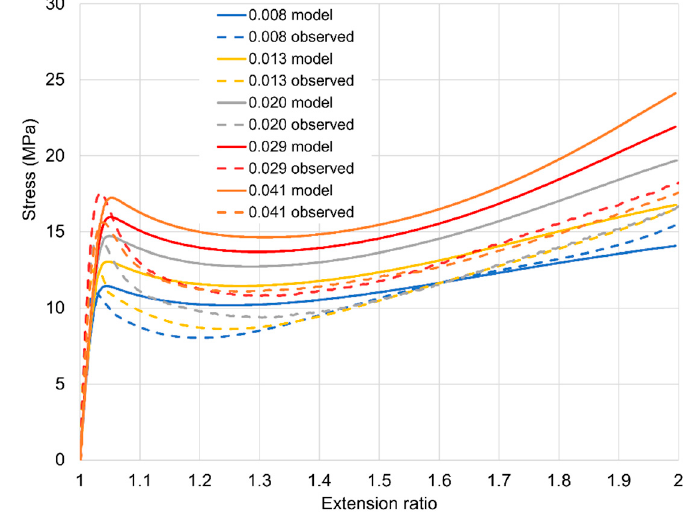
Figure 10. Uniaxial loading for the five highest strain rates, shown as octahedral rates in the key in s − 1 .